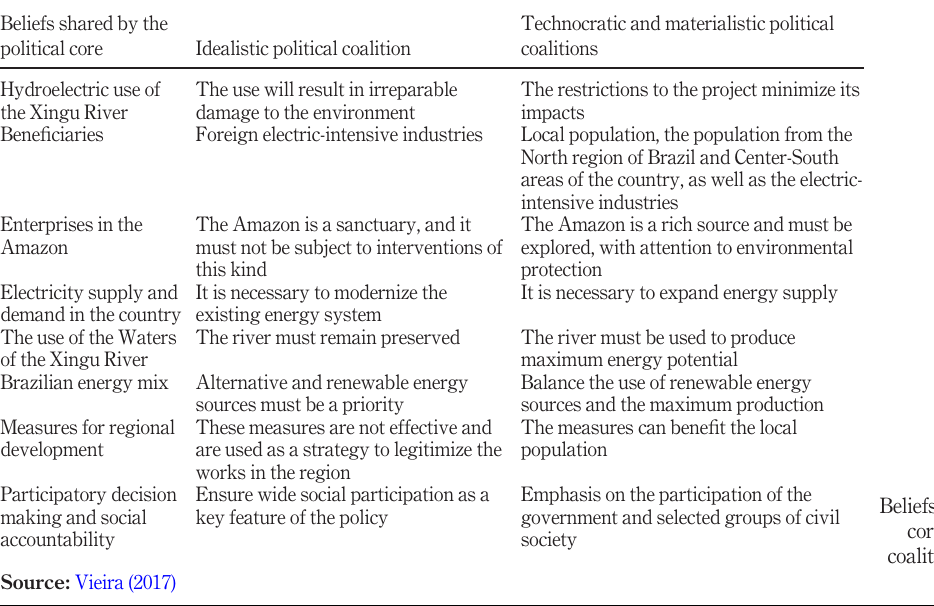
Table II. Beliefs of the